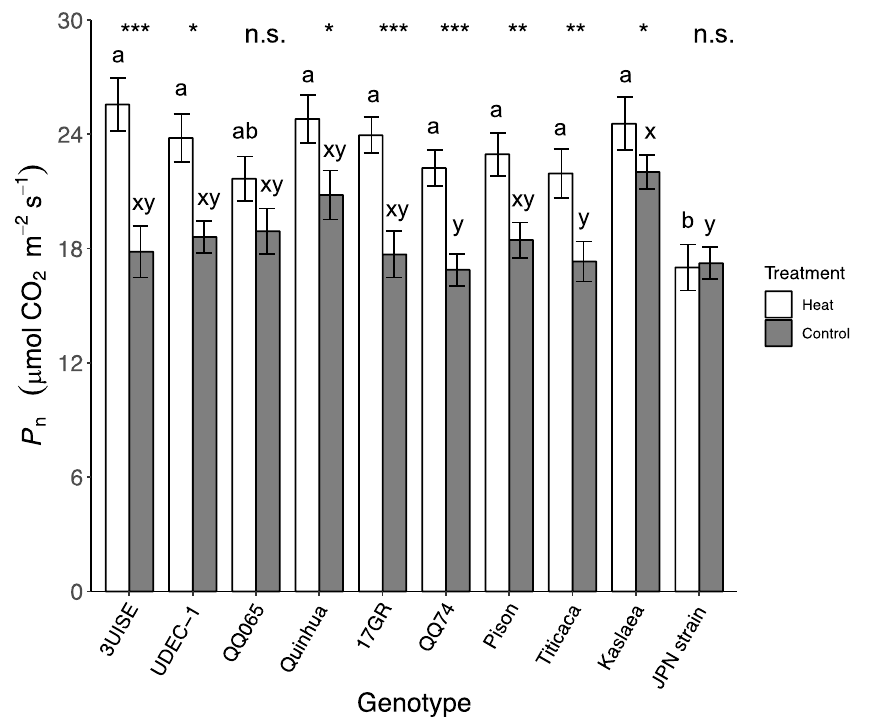
Figure 1. Photosynthetic rate (P n ; µ mol CO 2 m − 2 s − 1 ) of 10 quinoa genotypes exposed to a four-day heat treatment (45 ◦ C / 30 ◦ C) and control treatment (20 ◦ C / 14 ◦ C); day and night, respectively. Values are means ± standard error (SE) ( n = 32). Mean comparisons are shown for within genotype (asterisks and n.s.) and within temperature treatment (Heat: a to b; Control: x to y); di ff erent letters are significantly di ff erent at p < 0.05; *, p < 0.05; **, p < 0.01; ***, p < 0.001; n.s., not significantly different.